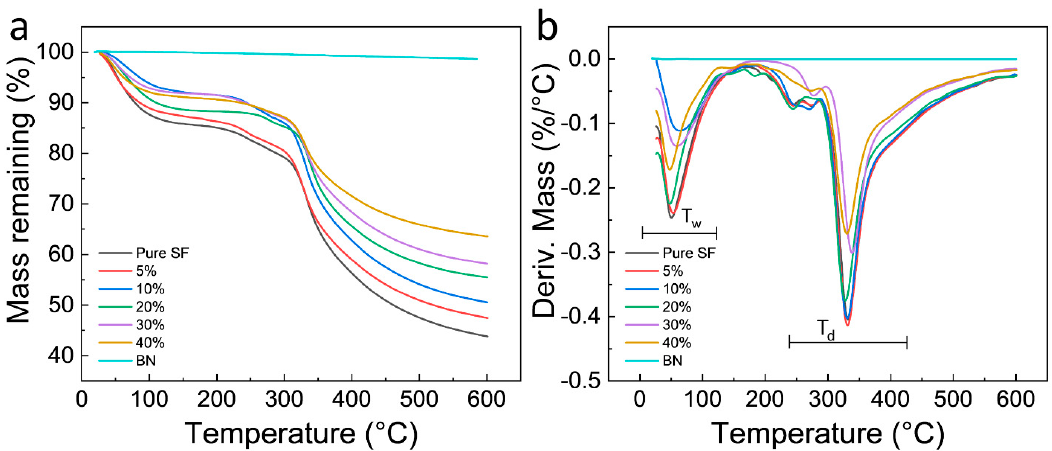
Figure 3. Thermogravimetric curves of ( a ) electrospun BNSF nanofibers and raw BN sheets; ( b ) displays the first derivative thermogravimetry (DTG) curves of the samples. Table 1. Thermal properties of pure silk fibroin (SF) nanofibers, different boron nitride silk fibroin (BNSF) nanofibers, and raw BN sheets.